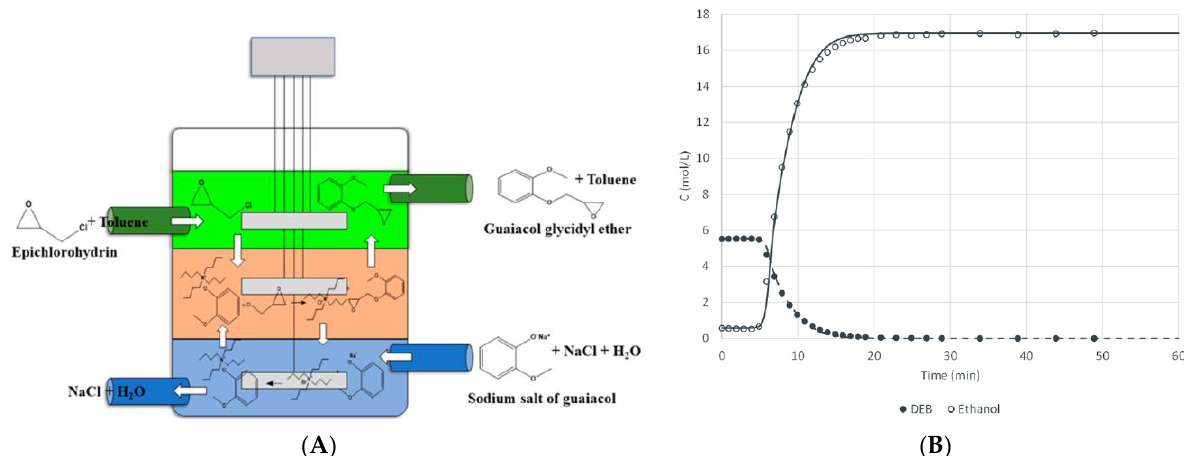
Figure 4. ( A ) Liquid – liquid – liquid reaction system in a continuous flow stirred reactor [8]. ( B ) Break- through curve between ethanol and DEB within an SMBR [11].